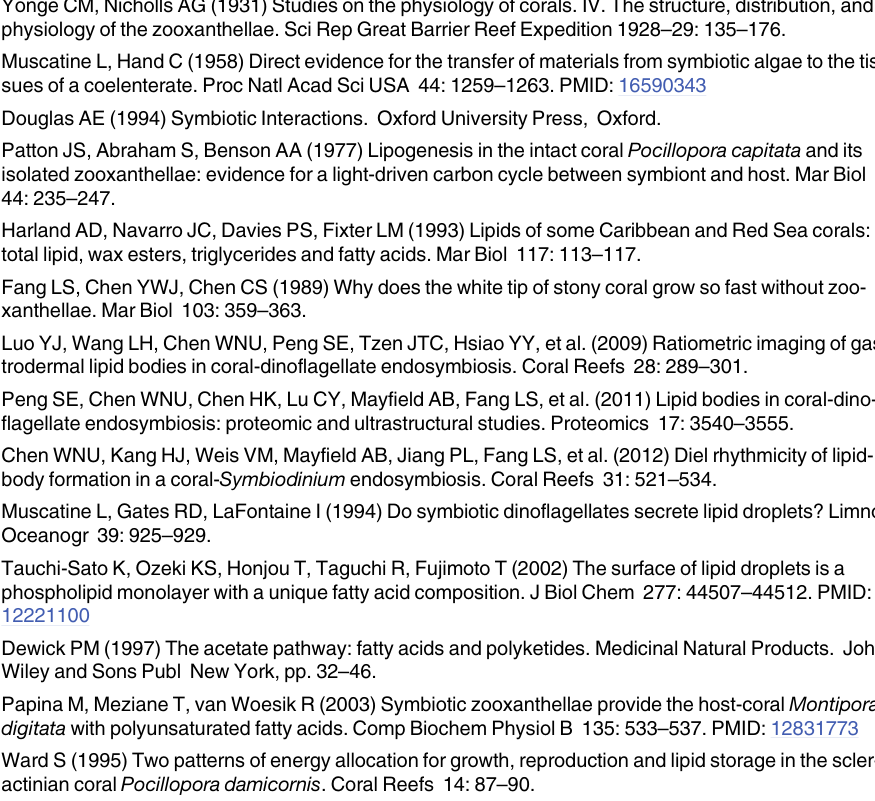
S6 Table. Concentrations of free fatty acid acyl chains in the host coral gastrodermal